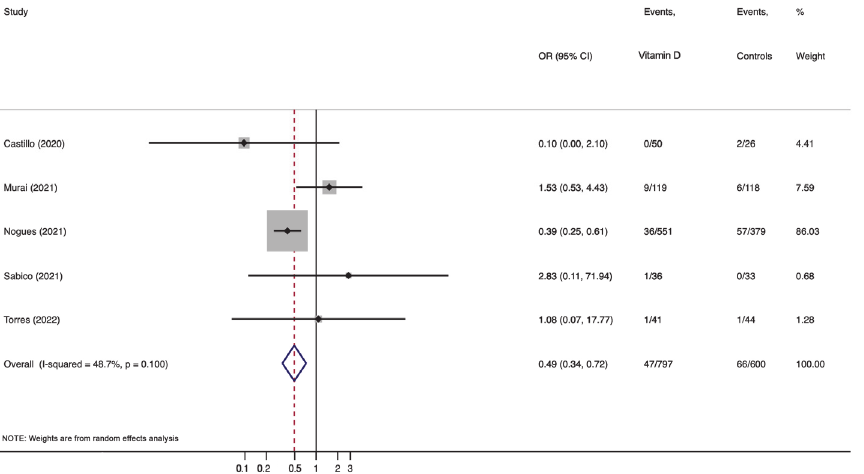
Figure 3. Forest plot of the association of protective effect of vitamin D supplementation with mortality in patients hospitalized with COVID-19. CI, confidence interval; OR, odds ratio [26,32,35–37].